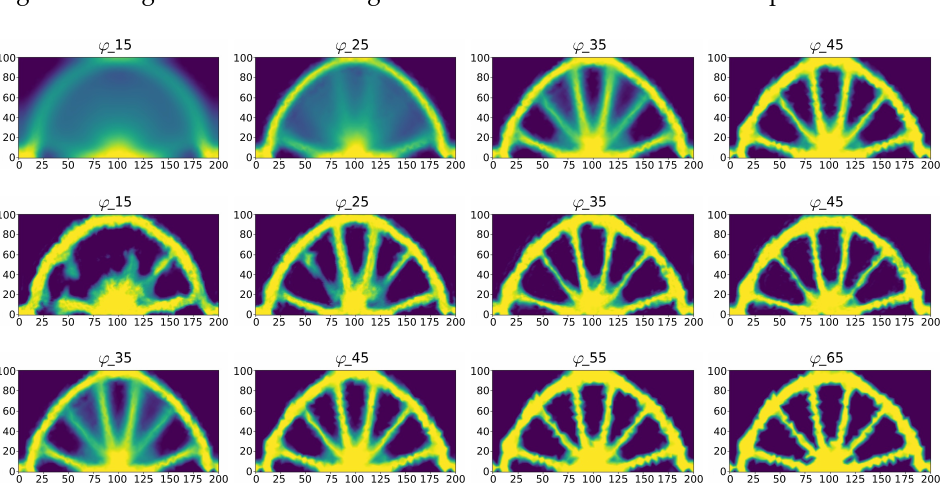
Figure 10. Input ϕ ( top row ), N 20